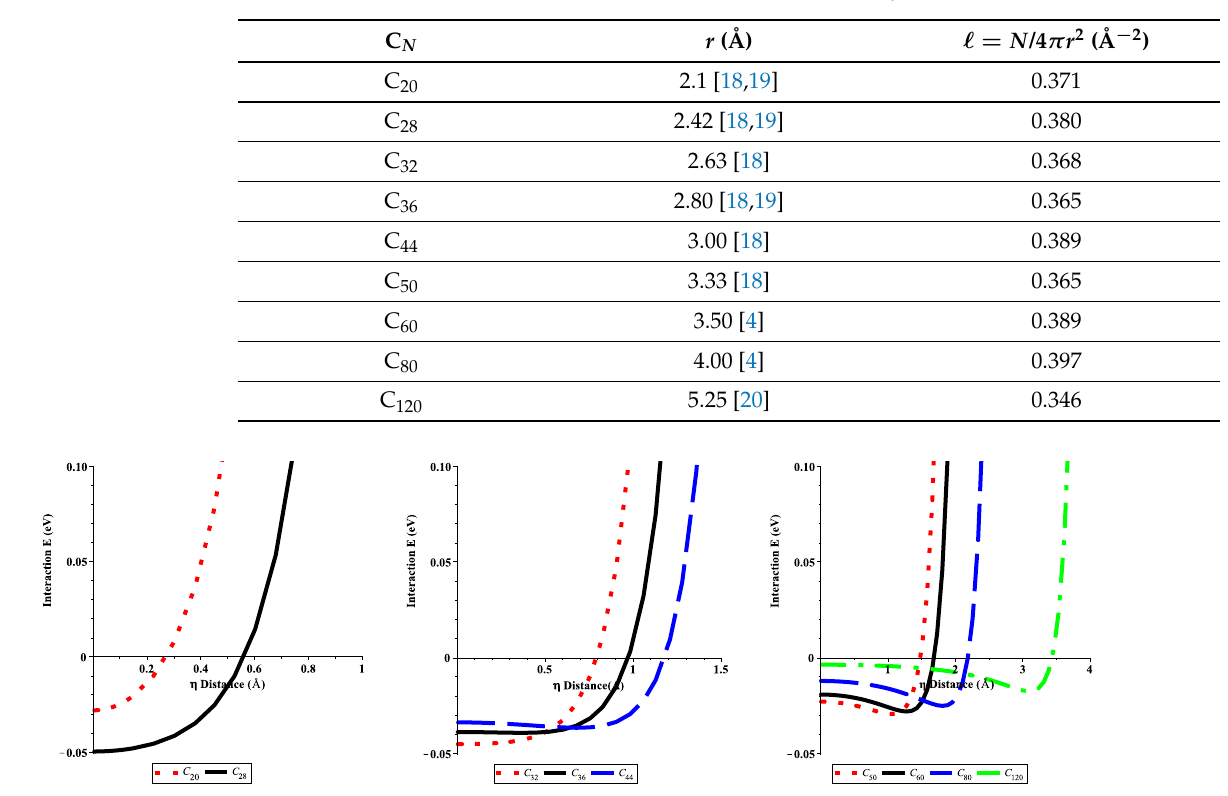
Table 1. Values of the radius r and the mean atomic surface density (cid:96) of the C N fullerenes.